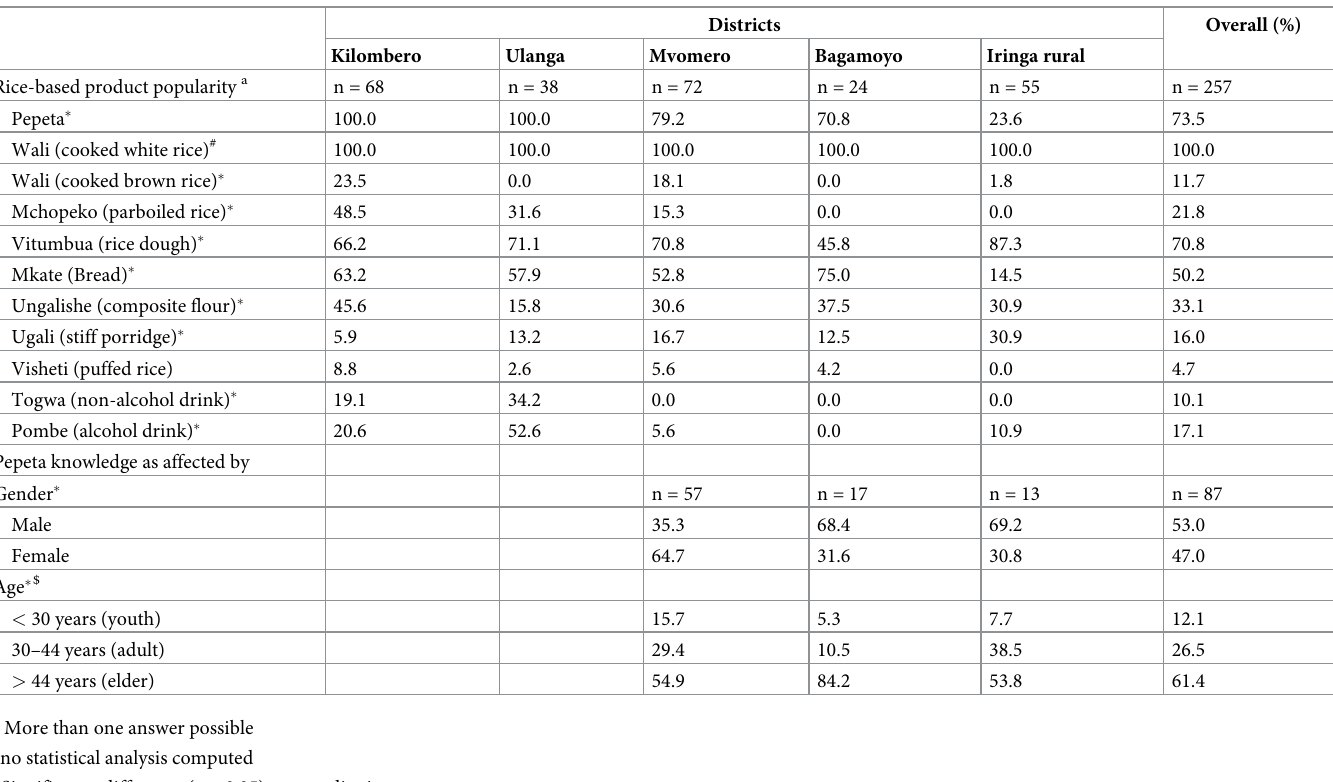
Table 4. Frequencies (as percentage) of respondents on awareness of rice-based products and pepeta knowledge in the study